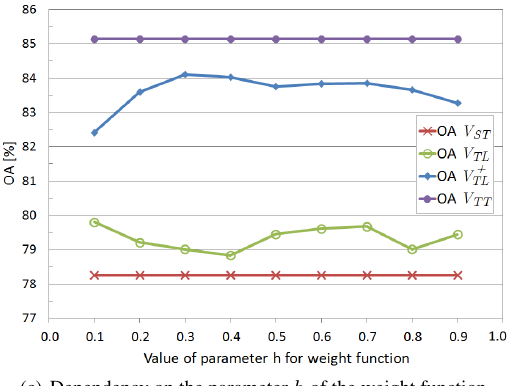
Figure 5: Dependency of the average overall accuracy (over 36 tests) on different parameter